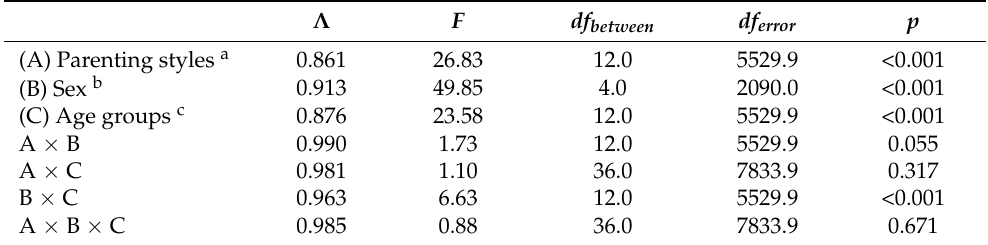
Table 3. MANOVA (4 a × 2 b × 4 c ) for academic/professional self-concept, self-esteem, delinquency during adolescence, and benevolence values.